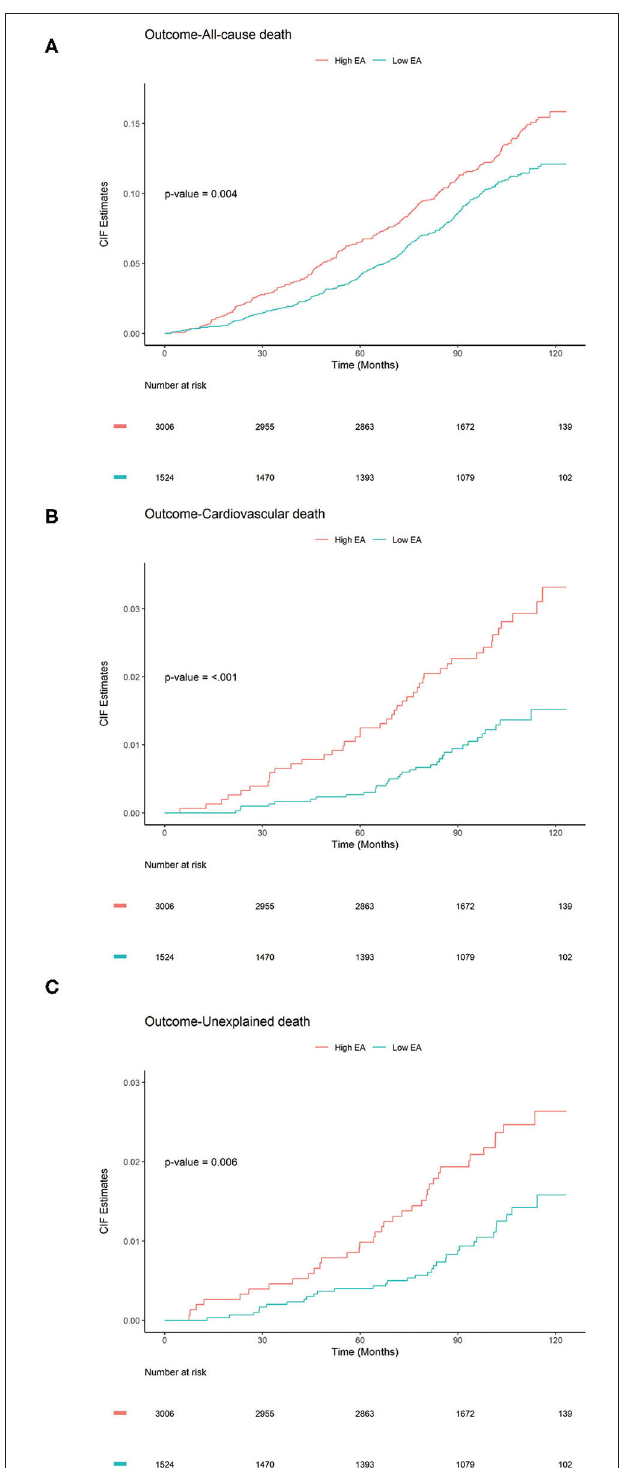
FIGURE 2 | Cumulative Incidence Function plots to compare the cumulative incidence of subjects ( N = 4,530) with ECG abnormality (EA) score (high, low). P -values were calculated using Gray’s test to elucidate whether significant differences exist in the different groups: (A) All-cause death, (B) CV death, and (C) Unexplained death.